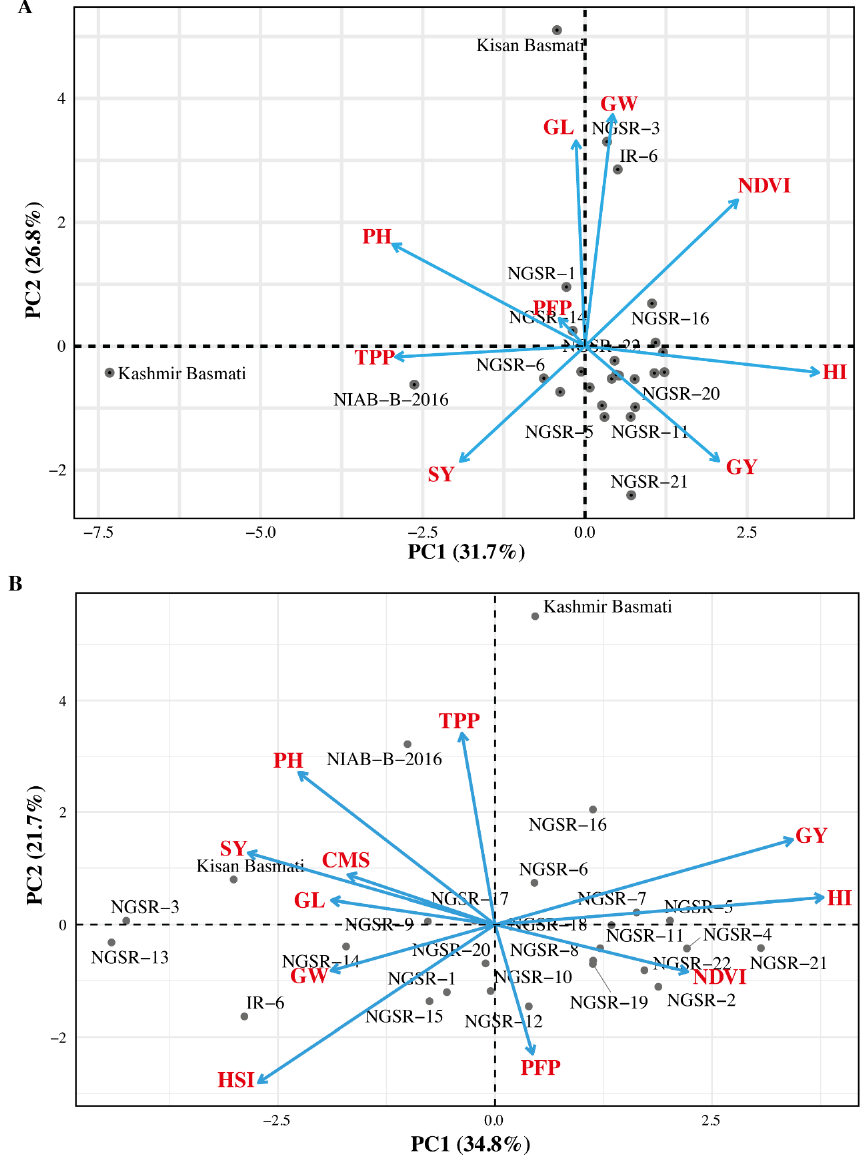
Figure 1. PCA under control ( A ) and heat stress ( B ) for 22 GSR lines and four controls and studied parameters. PH = Plant height (cm), TPP = Tillers per plant, GY = Grain yield per plant (g), SY = Straw yield per plant (g), HI = Harvest index, GW = 1000-Grain weight (g), GL = Grain length (mm), NDVI = Normalized difference vegetative index, PFP = Pollen fertility percentage, CMS = Cell membrane stability, and HIS = Heat susceptibility index.